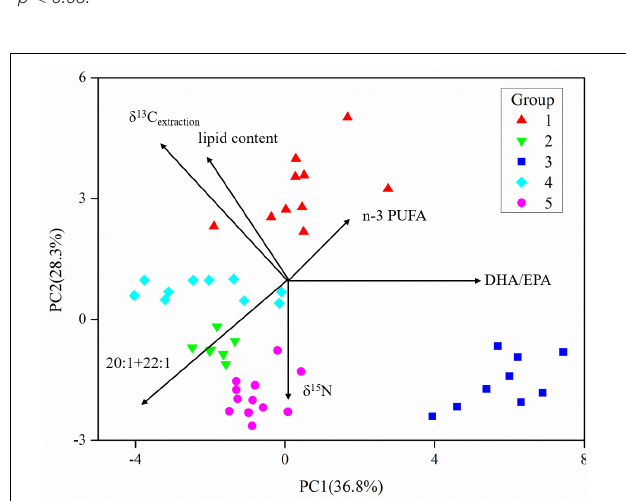
FIGURE 6 | Principal component analysis (PCA) of fatty acids and stable isotopes of the five groups of fishes (data in the Supplementary Material ) (the length of vectors represents their contributions to